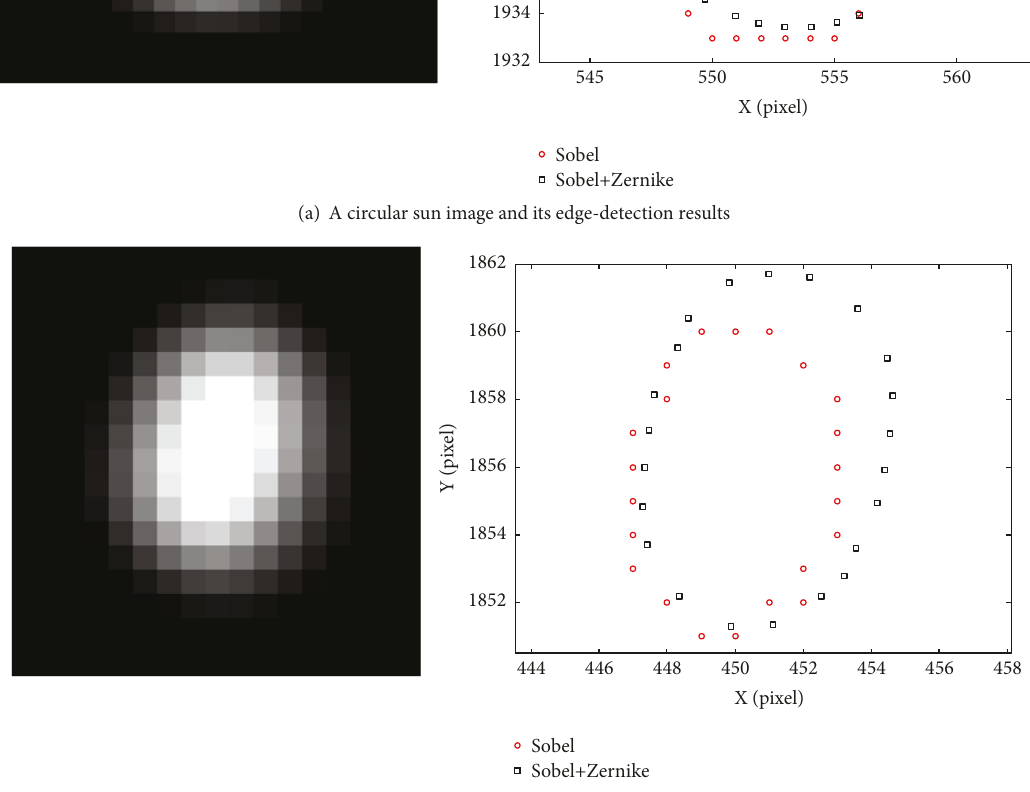
Figure 7: Two classic sun images and their edge-detection